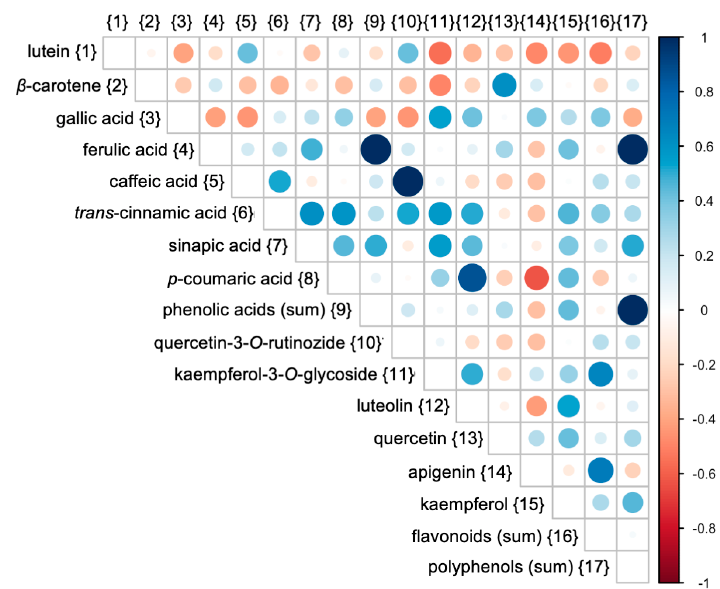
Figure 5. Pearson’s correlations between the concentrations of bioactive compounds (phenolics and carotenoids) identified in barley samples. Color (red/blue) and color intensity indicate the direction and the strength of the association, while size of the circle reflects statistical significance of the correlation ( p -value).